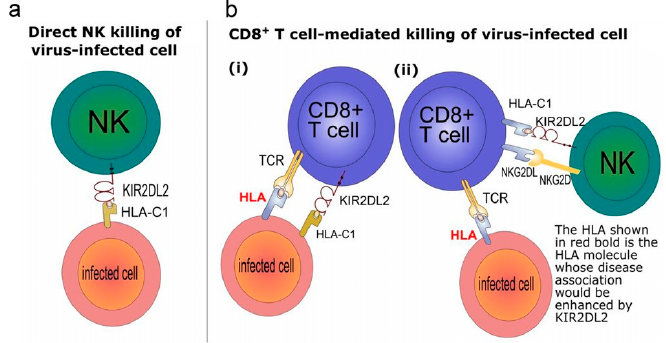
Figure 1. Mechanisms explaining inhibitory killer-cell immunoglobulin-like receptor (KIR) enhancement of human leukocyte antigen(HLA) class I associations.